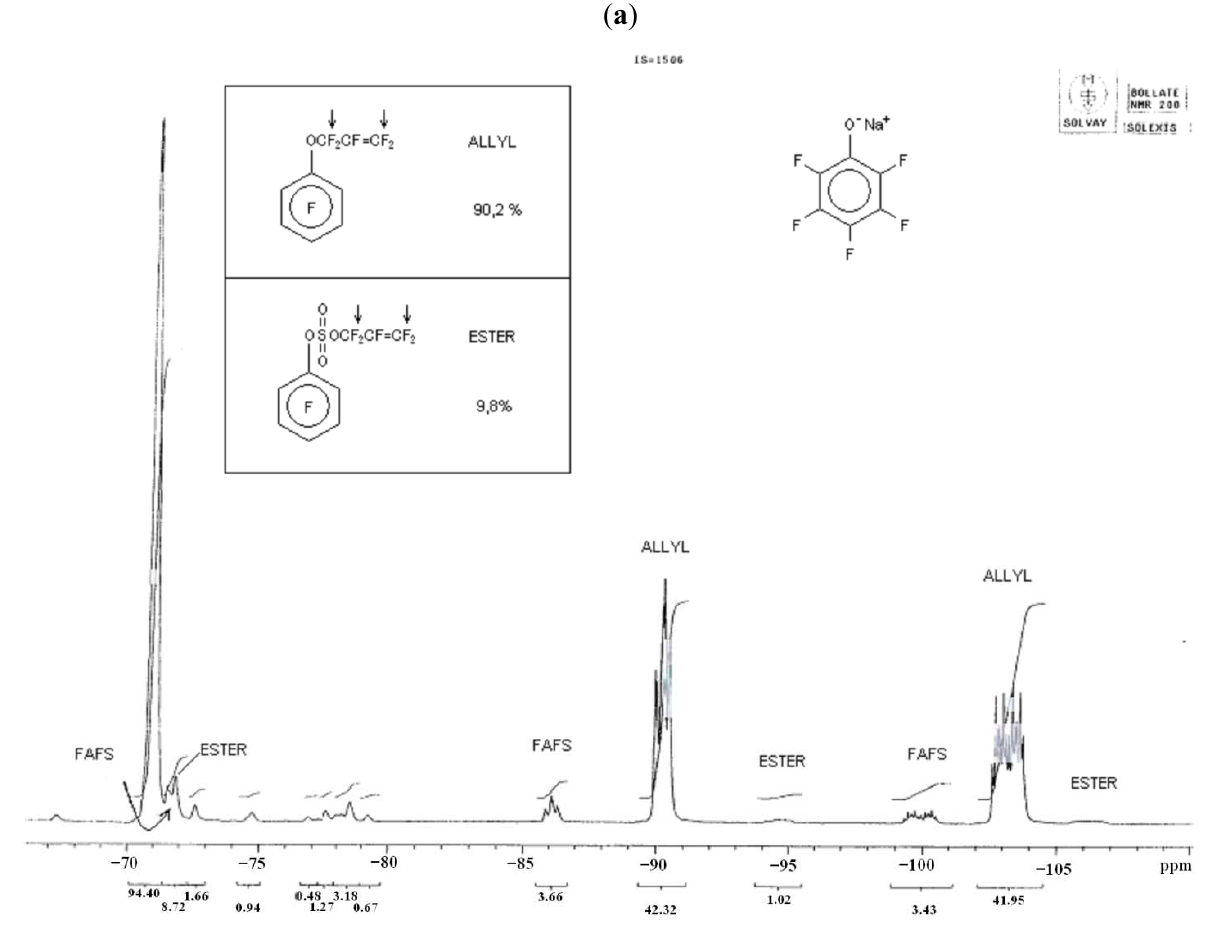
Figure 3. 19 F-NMR (200 MHz) spectrum of the Addition/Elimination (“Allyl”) vs. Substitution (“Ester”) products after reaction between FAFS and ( a ) C and ( c ) (C F O) 6 5 2